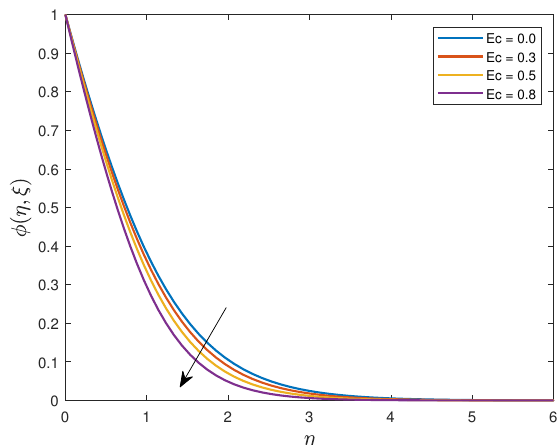
Figure 27. The influence of Ec on fluid